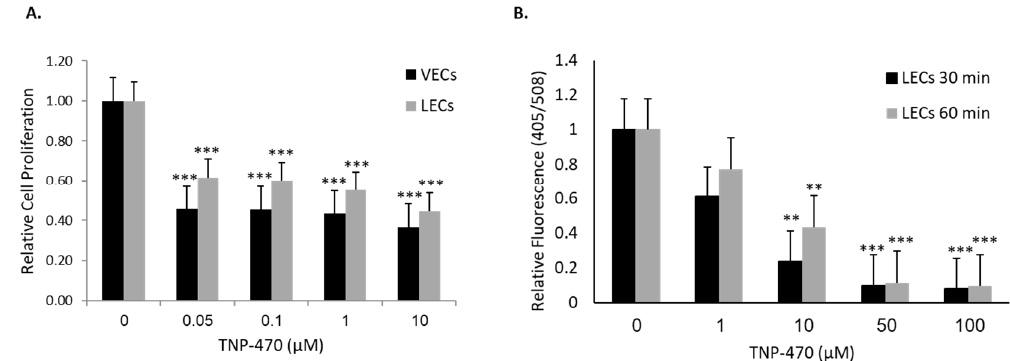
Figure 4. Inhibition of VEC and LEC proliferation and adhesion induced by the inhibition of MetAp2. ( A ) MetAp2 inhibition impairs the ability of both cell lines to proliferate. Cells were treated with di ff erent concentrations of TNP-470 for 72 h, after which an MTT assay was conducted to quantify their proliferation. A dose-dependent reduction was observed. *** p < 0.005, compared with the control of the same cells. n = 5. ( B ) HMVEC-dLyAd cells were stained with DiO and treated with TNP-470; they showed a significant decrease in their ability to adhere. The relative fluorescent cell population was quantified using the Synergy HT multi-mode microplate reader. n = 4. ** p < 0.01, *** p < 0.001. The results are presented as mean ± SEM.